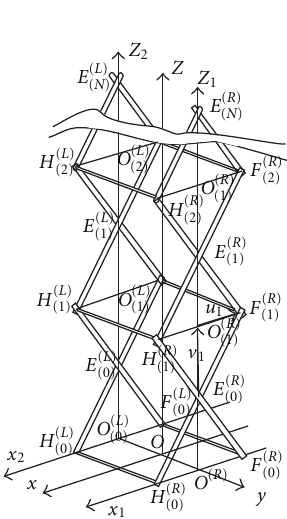
Figure 4: Pantograph